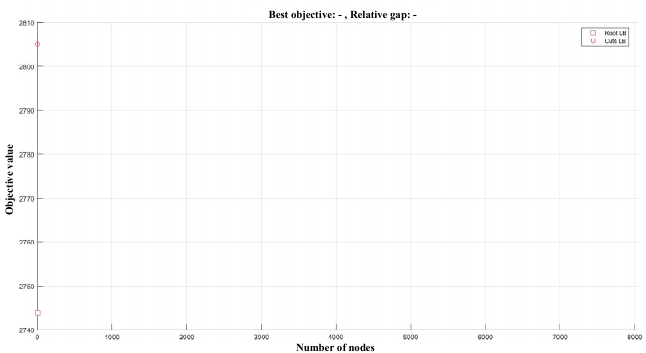
Fig. 6. Fast demand fulfillment results of the Intlinprog solver Routes (Node ID)